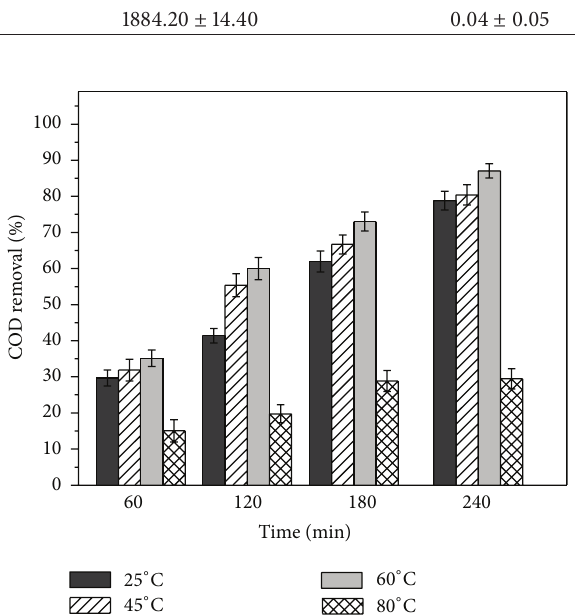
Figure 8: Effect of temperature on color removal. Experimental conditions: UV/1% H 2 O 2 and initial pH of 10.